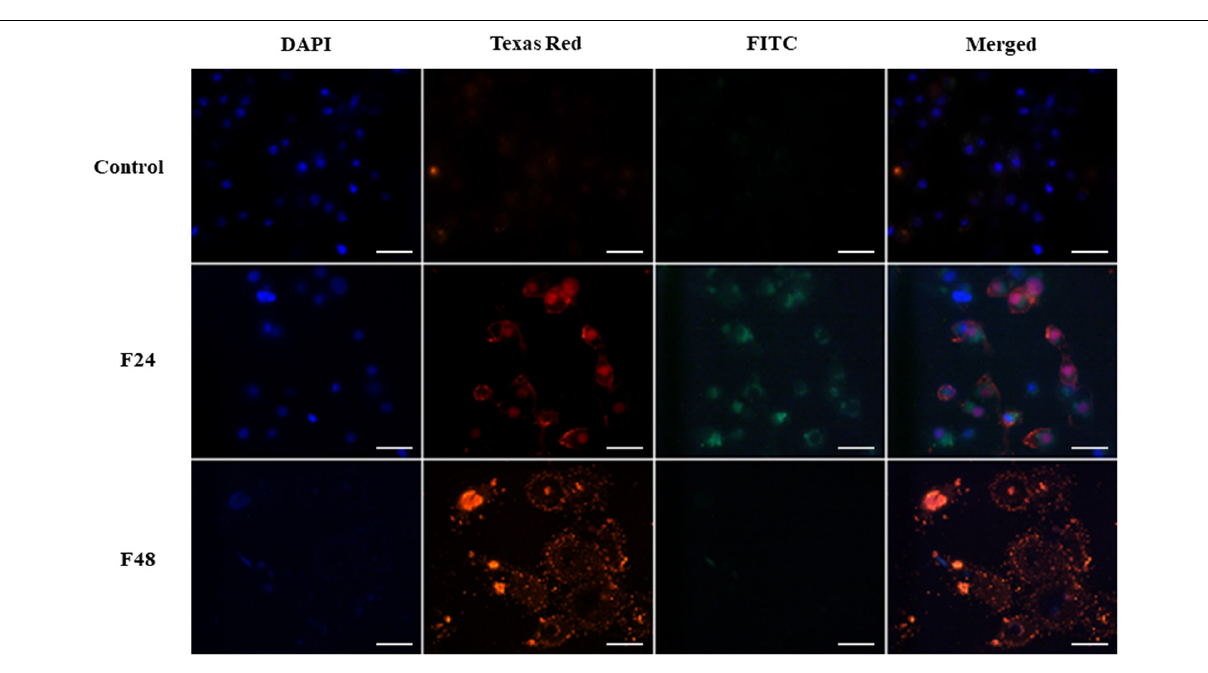
infection; F48- larvae sampled 24 h after 24-h exposure) is given in Figure 2 . In the control, very weak fluorescence was observed on Texas Red and FITC, which indicated that